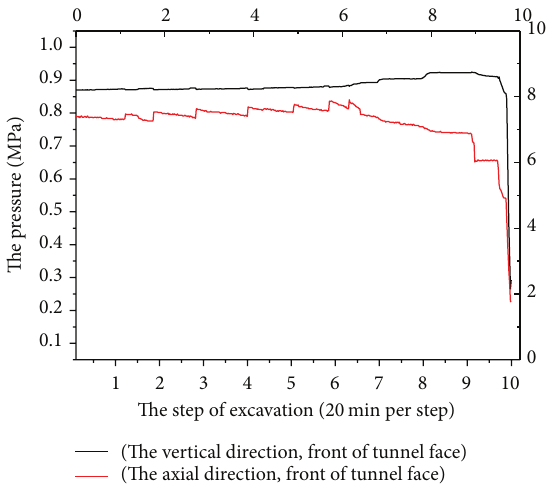
Figure 10: Internal pressure of measuring points (front of tunnel